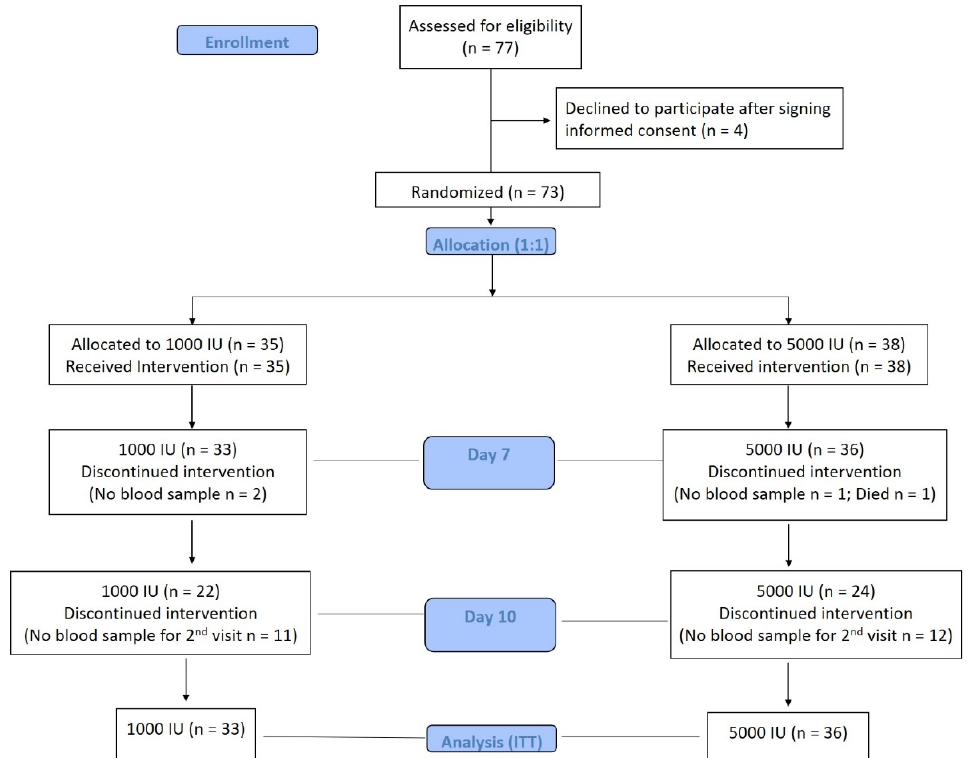
Figure 1. Flowchart of